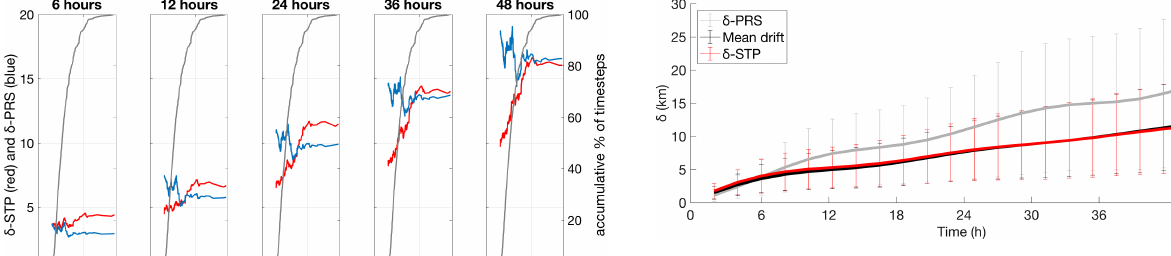
Figure 8. Time evolution of the mean separation δ STP and δ PRS [km] between the truth and forecast trajectories using the truth and STP–PRS currents and the mean drift with BoB system data for 2015. The mean drift of the truth forecasted trajectories is also com- puted for each simulation period (the means drift is considered the average of the distances moved by each particle during 48h).